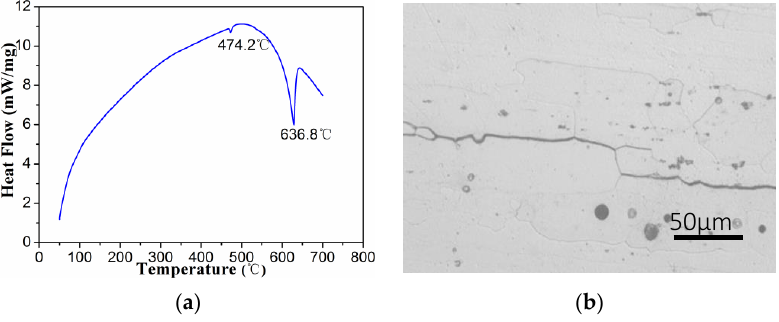
Figure 10. ( a ) The DSC results of the as-spray-deposited specimen; and ( b ) the microstructure of the sample after hot extrusion at 470 °C with an extrusion ratio of 6.2.